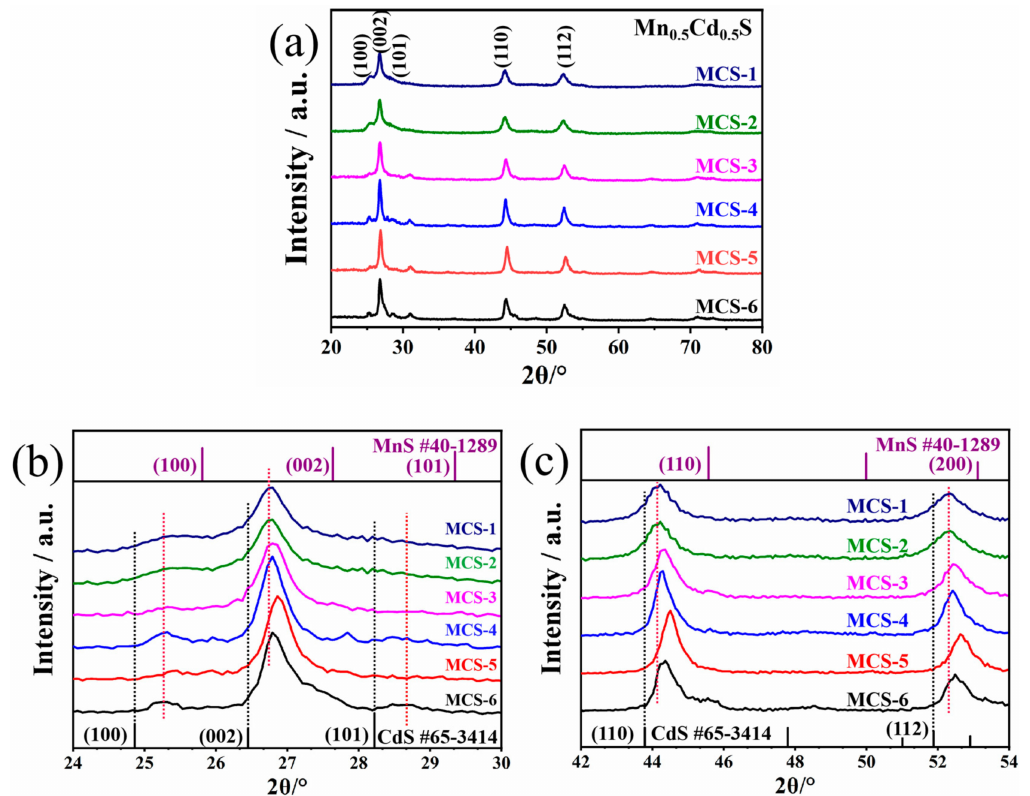
Figure 2. ( a ) XRD patterns of the MCS products with different TAA addition. ( b ) XRD diffraction patterns of 24–30 ◦ . ( c ) XRD diffraction patterns of 42–54 ◦